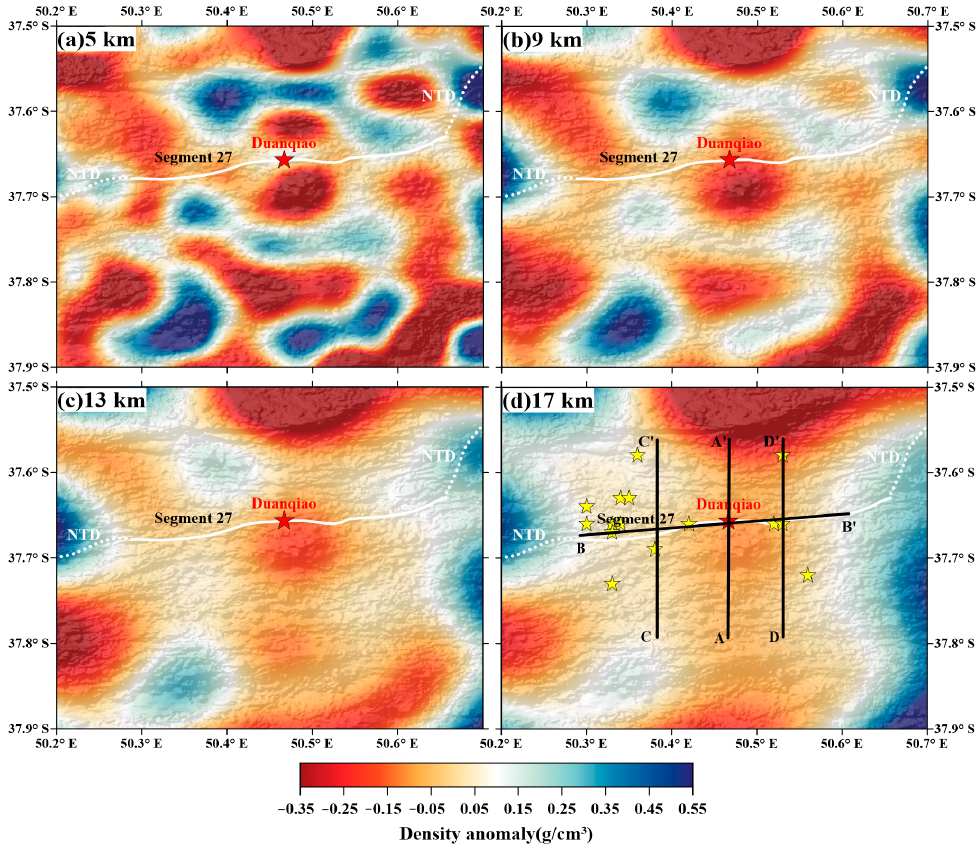
Figure 8. Inverted density variations at depths of ( a – d ). Locations of four cross-sections are shown in ( d ): AA ′ , CC ′ , and DD ′ are across segment 27’s axis, and BB ′ is along segment 27’s axis. The solid white line and dotted white lines represent segment 27’s axis and two NTDs, respectively. The red star denotes the Duanqiao hydrothermal field. Yellow stars represent several hydrothermal plume anomalies [17].